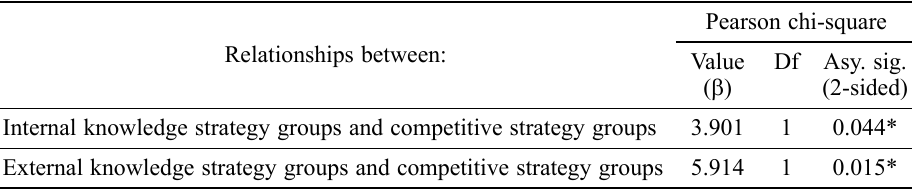
Table 4. χ 2 test results between knowledge strategy groups and competitive strategy groups Relationships